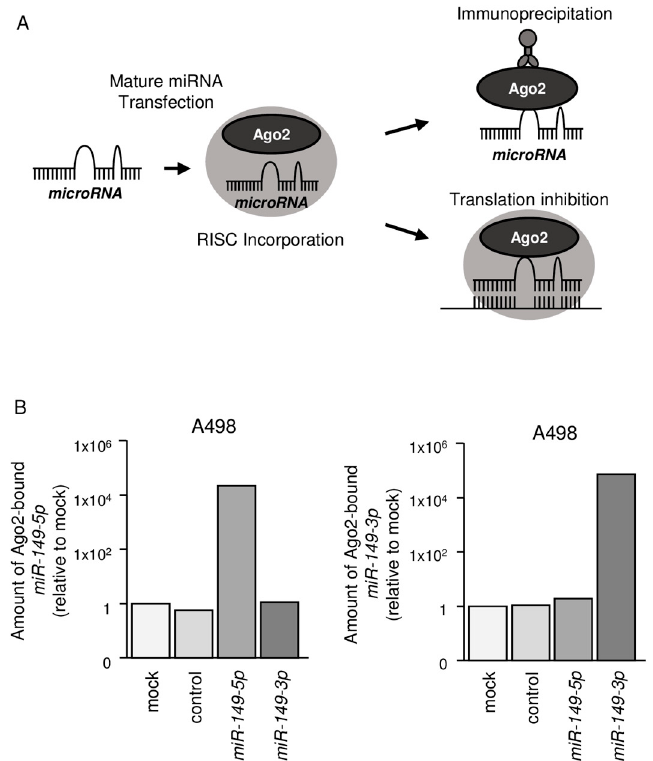
Figure 2. Both miR-149-5p and miR-149-3p bound to Ago2. ( A ) Schematic illustration of microRNA (miRNA) detection method. Isolation of miRNA-induced silencing complex (RISC) incorporated miRNAs by Ago2 immunoprecipitation; ( B ) Expression levels of miR-149-5p and miR-149-3p after transfection with miR-149-5p or miR-149-3p . We used miR-26a as an internal control.